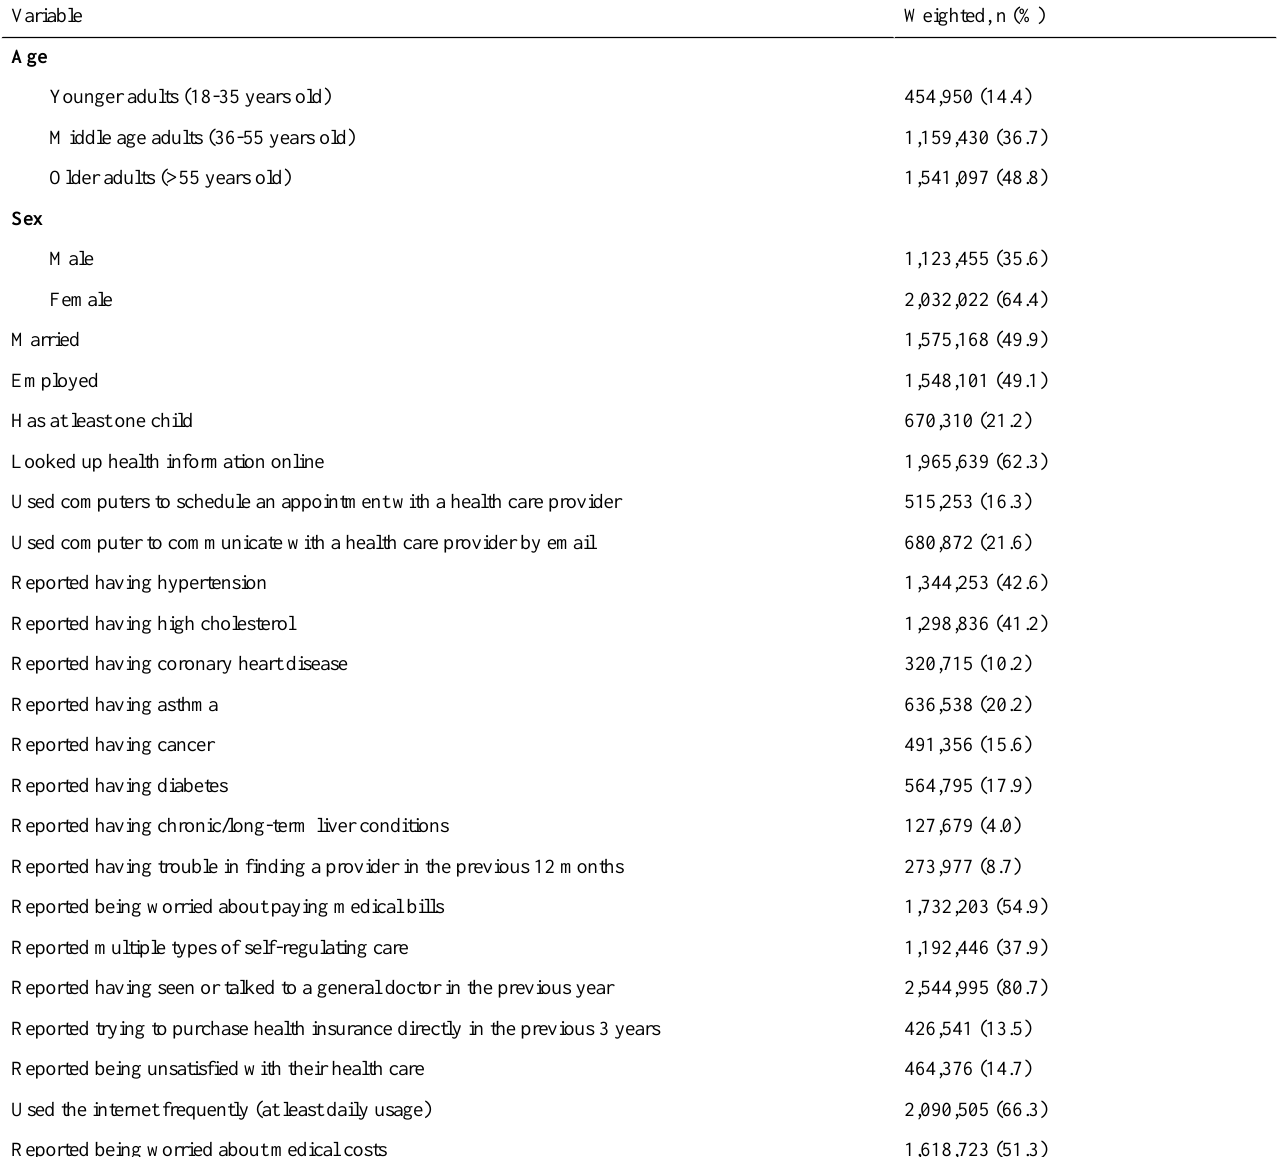
Table 1. The characteristics of the sample of survey respondents who reported having